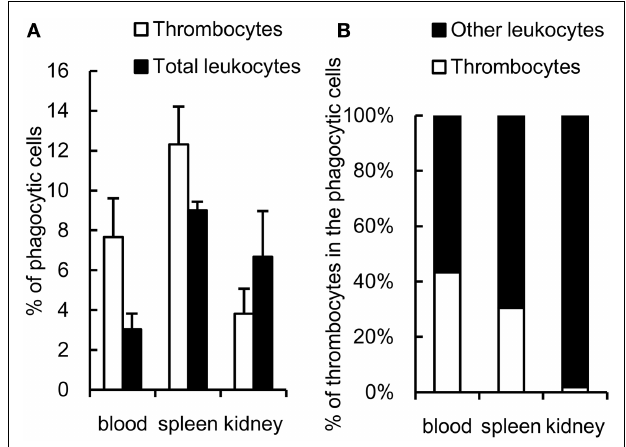
FIGURE 5 | In vivo study of common carp phagocytic thrombocytes and other leukocytes 3h after intravenous injection . (A) Percentage of phagocytic cells in HB8 mAb + thrombocytes and total leukocytes in each tissue. (B) Percentage of thrombocytes and other HB8 mAb - leukocytes in phagocytic populations in each tissue. Data are expressed as the average of three independent experiments, shown as mean ±